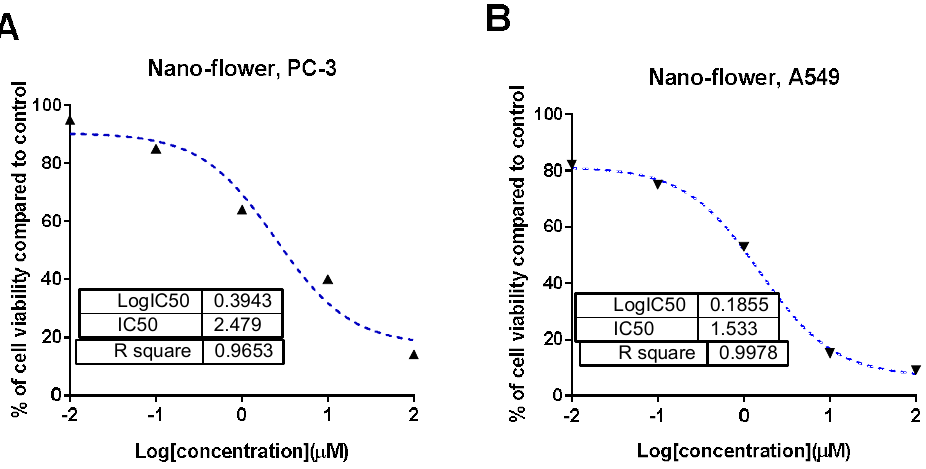
Figure 3. Percentage of cell viability vs. log [con. µ M], R square ≈ 1 using the GraphPad prism software. ( A ) cytotoxicity of flower extract AgNPs against PC-3 cells. ( B ) cytotoxicity of flower extract AgNPs against A549 cells.